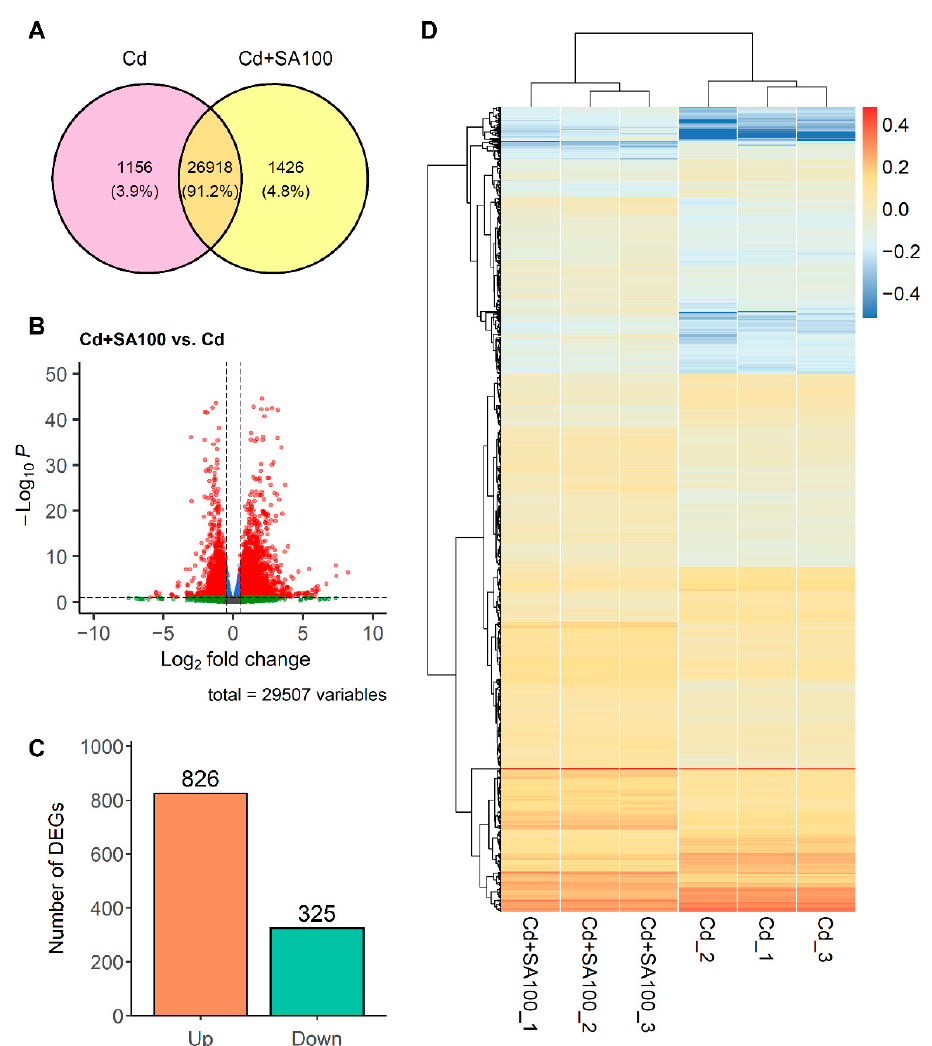
Figure 4. Differential gene expression in the root of Tartary buckwheat plants cultivated in soil with 2.0 mg kg − 1 Cd contamination with and without 100 µ mol L − 1 salicylic acid treatment. Differential gene expression analysis was applied using R package “DESeq2”. A default significance cutoff of 0.1 was applied in the analysis and the cutoff for low counts was four. A threshold of absolute log 2 fold-change greater than 0.5 was applied to increase the reliability of the analysis with a sample size of three. ( A ) Venn diagram of the expressed genes between the Cd (plant group without salicylic acid treatment) and the SA100 (plant group with 100 µ mol L − 1 salicylic acid treatment); the overlapping region shows the shared gene expressed between the two groups, and the non-overlapping region is genes exclusively detected for each group. ( B ) Volcano plot of the genes. The plot was created using the R package “EnhancedVolcano”. Each point represents a gene, and the red points denote the differentially expressed tested genes with adjusted p -value > 0.1 and absolute value log 2 fold- change larger than 0.5. The horizontal dash line indicates the adjusted p -value of 0.1, and the vertical dash lines indicates the log 2 fold-change of − 0.5 and 0.5. ( C ) Number of differentially expressed genes categorized as either upregulated (Up) or downregulated (Down) genes. ( D ) Heatmap of all differentially expressed genes with hierarchical clustering. SA100_1, SA100_2, and SA100_3 each denote one of the three plant replicates from the plant group cultivated in the soil with 2.0 mg kg − 1 Cd contamination with 100 µ mol L − 1 salicylic acid treatment. Cd_1, Cd_2, and Cd_3 each denote one of the three plant replicates from the Cd group cultivated in the soil with 2.0 mg kg − 1 Cd contamination without salicylic acid treatment. The color indicates the expression level in z-score of the TPM values of all differentially expressed